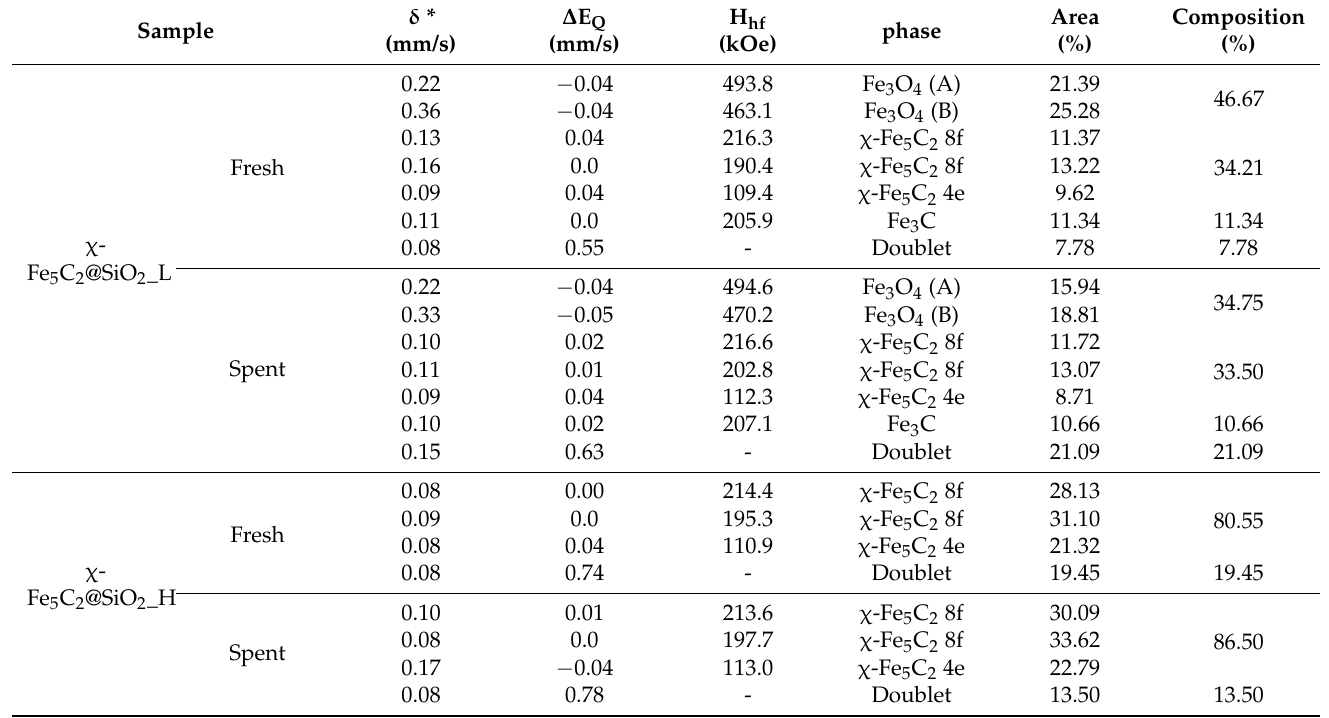
Figure 10. MES spectra of ( a ) fresh χ − Fe 5 C 2 @SiO 2 _L catalyst, ( b ) fresh χ − Fe 5 C 2 @SiO 2 _L catalyst, ( c ) fresh χ − Fe 5 C 2 @SiO 2 _H catalyst, and ( d ) spent χ − Fe 5 C 2 @SiO 2 _H catalyst. Table 2. Mössbauer parameters of χ -Fe 5 C 2 @SiO 2 _L and χ -Fe 5 C 2 @SiO 2 _H